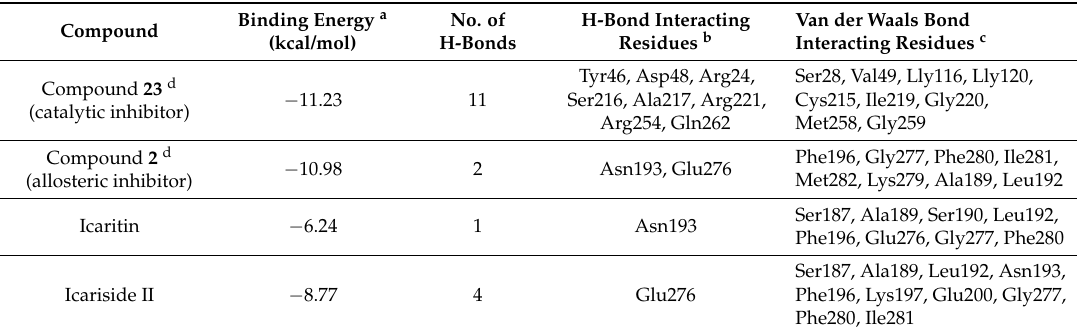
Table 3. Binding site residues and docking scores of compounds with PTP1B as determined by AutoDock 4.2.